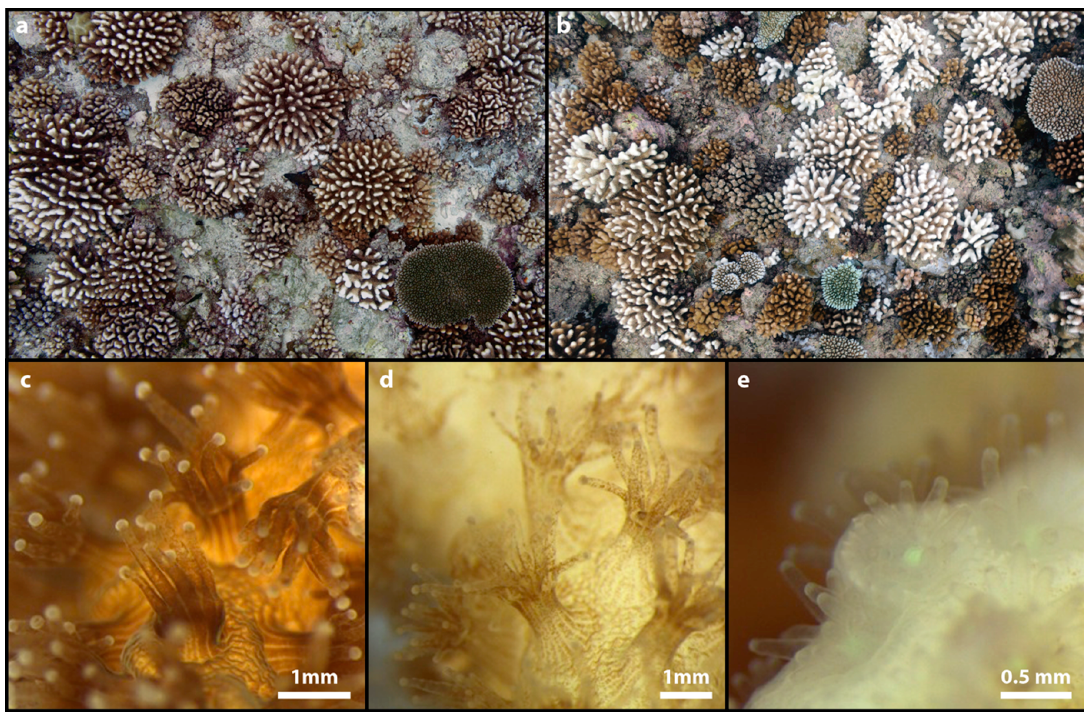
Figure 1. Coral bleaching. The upper photographs show a reef landscape (reef slope) before ( a ) and during ( b ) the massive bleaching event of 2016 at Moorea, French Polynesia. The bottom macro-photographs show a close-up lateral view of the polyps of the scleractinian coral Pocillopora damicornis experiencing bleaching: unbleached (healthy) polyps with visible Symbiodiniaceae ( c ), partially bleached polyps with low density of Symbiodiniaceae ( d ), and bleached polyps without Symbiodiniaceae and transparent tissue ( e ). Photographs are courtesy of Y. Chancerelle (a, b), and L. Hédouin (c–e) (CRIOBE, Moorea).